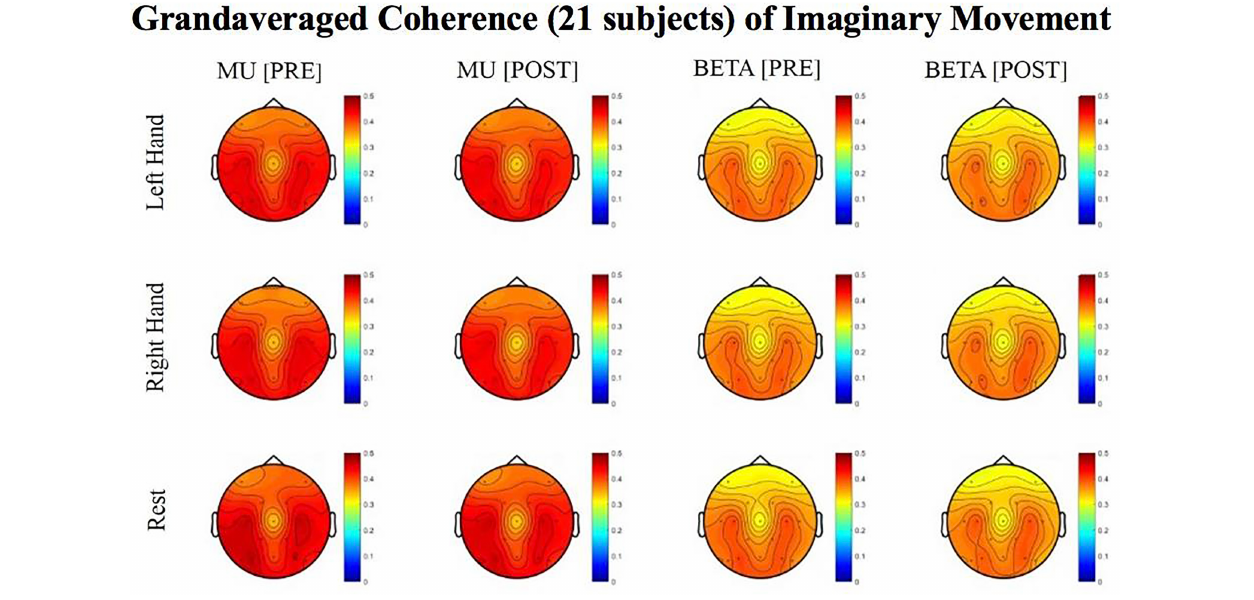
FIGURE 8 | Topoplots of grand averaged coherence values at group level ( n = 21) for Mu (8–12 Hz) and Beta (18–26 Hz) bands during imaginary movement trials. Prescreening, open-looped training (PRE) and open-looped post screening BCI training (POST) runs (color bar: [0 = blue – 0.5 = red]). The majority of participants had a right lateralized lesion.